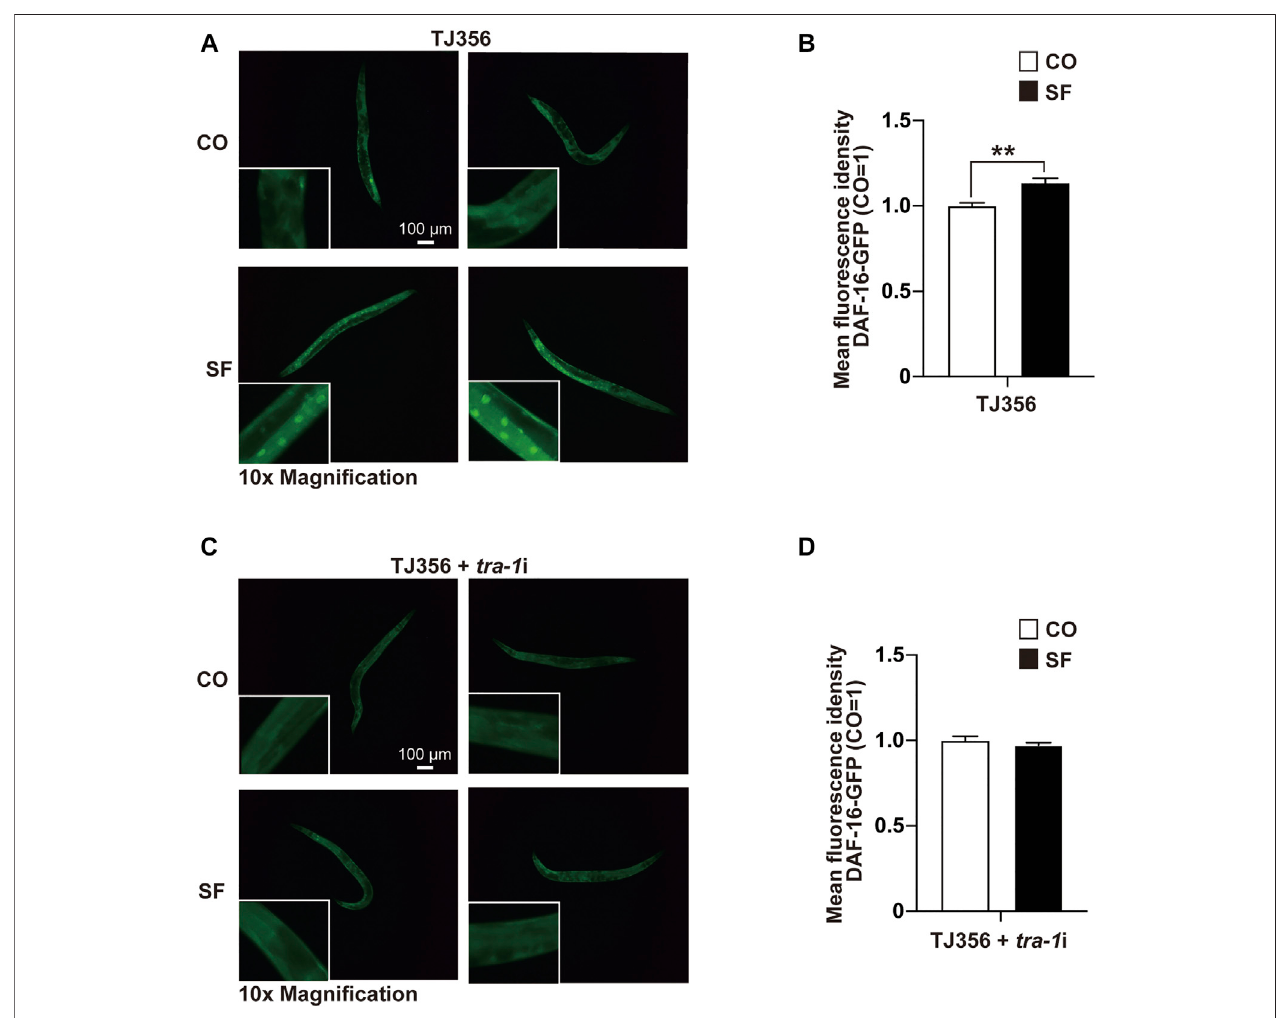
FIGURE 4 | TRA-1 mediates sulforaphane-induced DAF-16 nuclear translocation. (A) Synchronized TJ356 C. elegans L4 larvae expressing a daf-16 -GFP fusion gene were fed 100 µM sulforaphane (SF) or not (CO). Two days later, the nuclear translocation of DAF-16 was evaluated by detecting green fl uorescent spots by fl uorescence microscopy. Images were taken at × 100 magni fi cation, and the inserts had a × 10 magni fi cation. The scale bar indicates 100 µm. (B) The fl uorescence intensity was quanti fi ed by ImageJ, and the means, standard deviations and statistical signi fi cance are shown in the diagram. (C,D) Synchronized TJ356 L4 larval nematodes were treated and evaluated as described above. The data are shown as means ± SEM. * p < 0.05, ** p < 0.01.